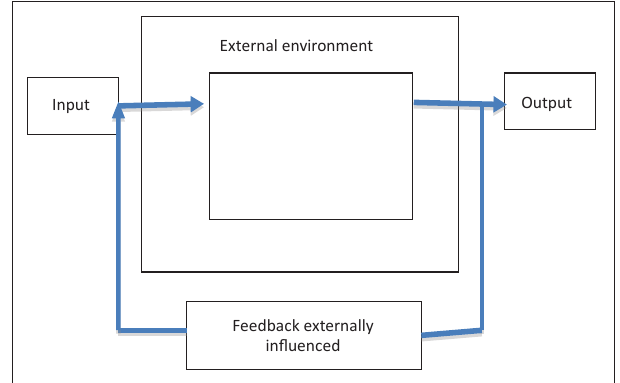
FIGURE 1: Extrinsic feedback (adapted from Skyttner,